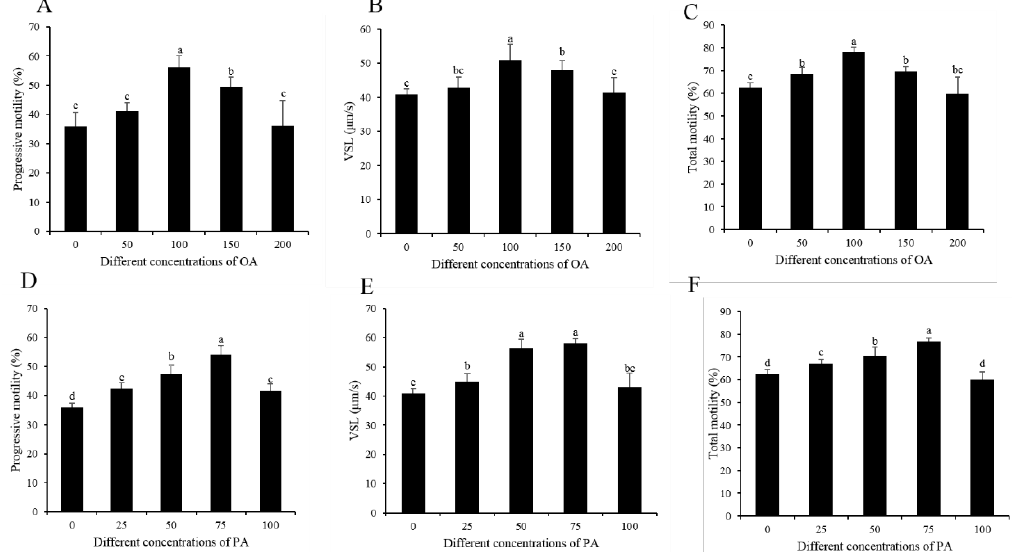
Figure 2. ( A – D ) Dynamic changes in the sperm parameters by the addition of OA and PA to the diluted medium after seven days of preservation: ( A , D ) progressive motility, ( B , E ) VSL, and ( C , F ) total motility. Values are specified as the mean ± standard deviation (SD). Columns with di ff erent lowercase letters di ff er significantly ( p < 0.05). VSL: straight-line